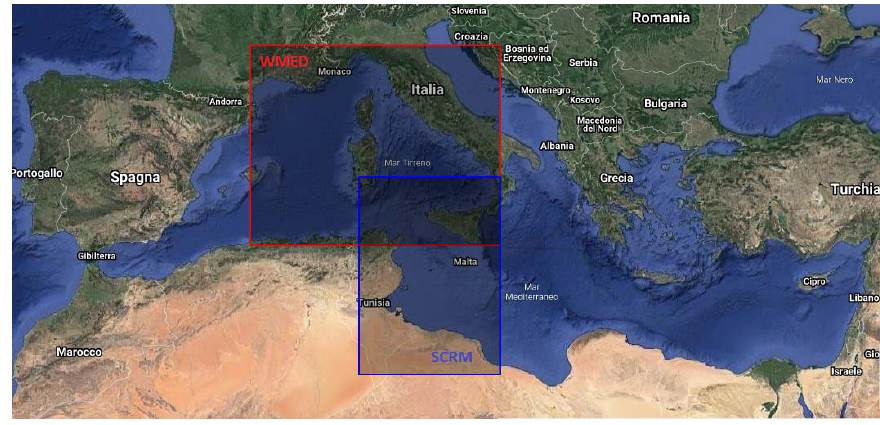
Figure 2. Scheme of the computational domains of the limited area models (LAMs): the WMED6041 (red) and SCRM6041